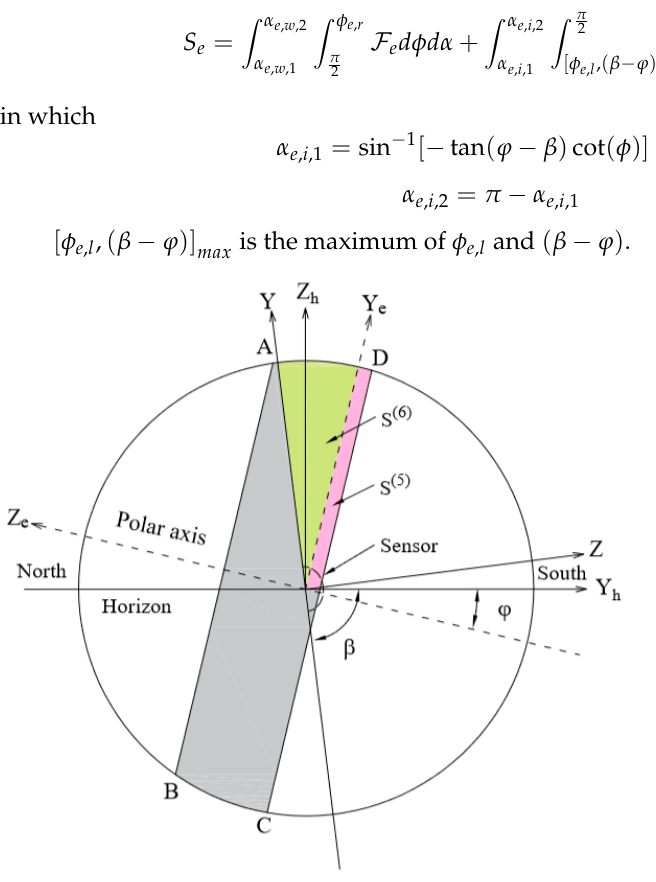
Figure 16. Schematic diagram for the calculation of S e while φ e , l < π /2 < φ e , r and β > φ e , l + ϕ .